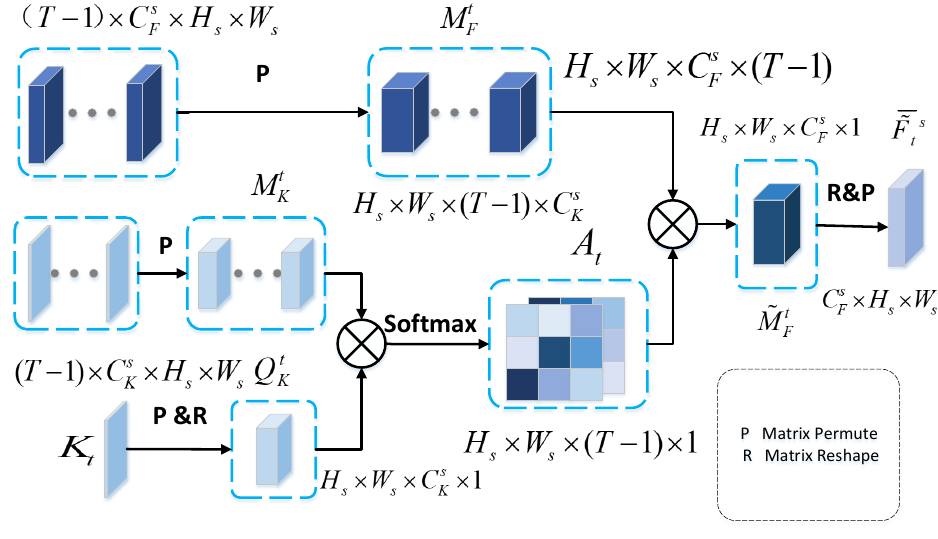
Figure 4. Temporal Attention